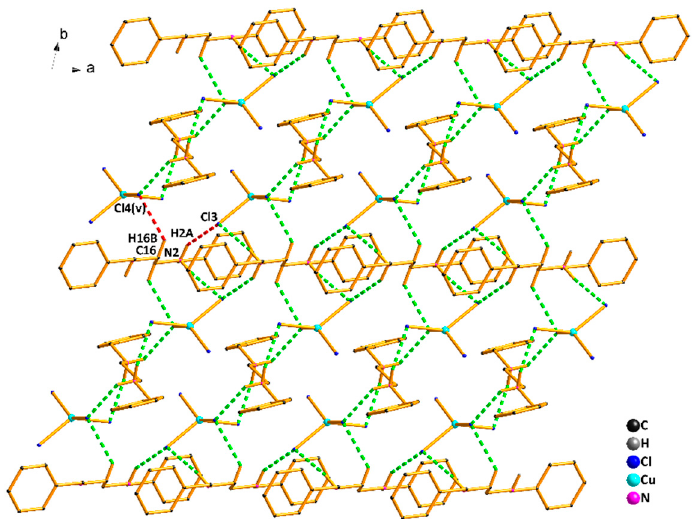
Figure 5. The 2D network structure of compound ( 2 ).Symmetry codes: (iii) 1 − x, − y,1 − z; (iv) 1+x,y,z; (v) 1 − x,1 − y,1 − z.